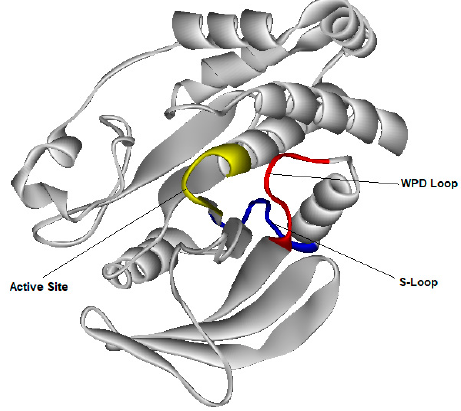
Figure 6. Fragment of PTB-1B structure (according to PDB ID: 1t49) .